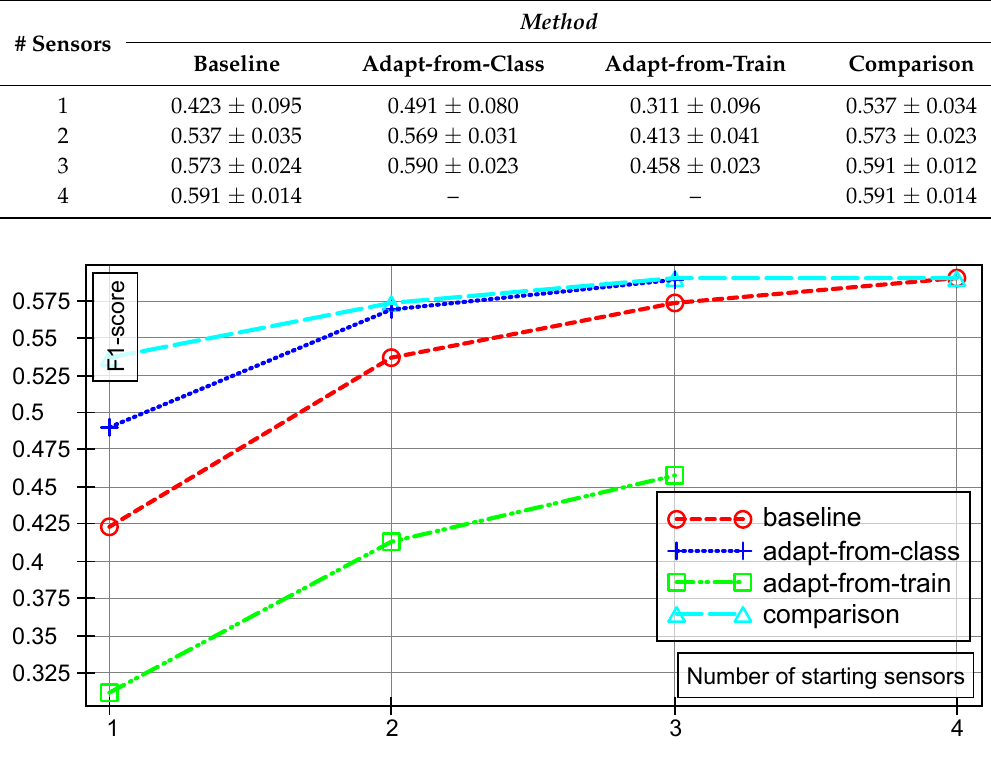
Figure 4. Training F-scores with the same notation as in Figure 3. In each case, one additional sensor is added to the